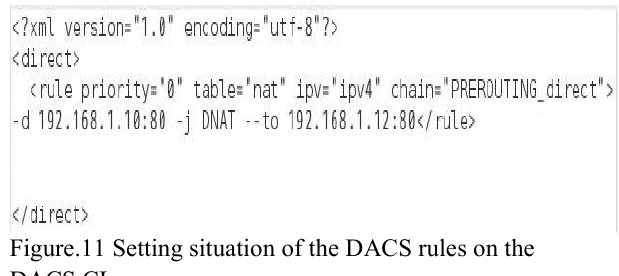
Figure.11 Setting situation of the DACS rules on the DACS CL